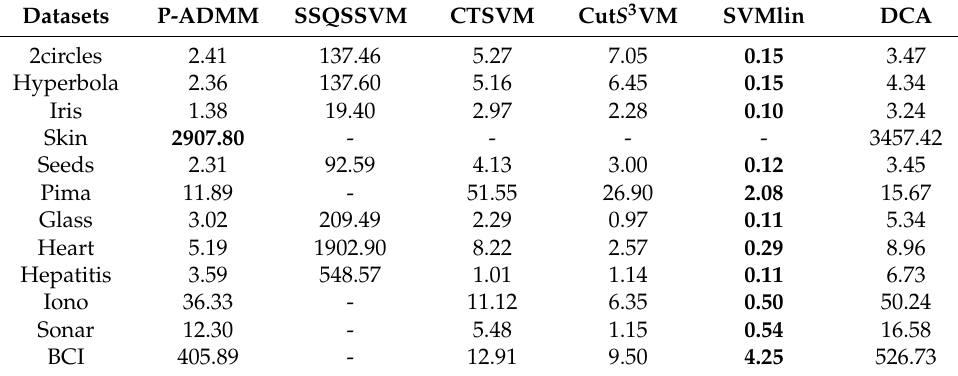
Table 3. CPU time(s) for data